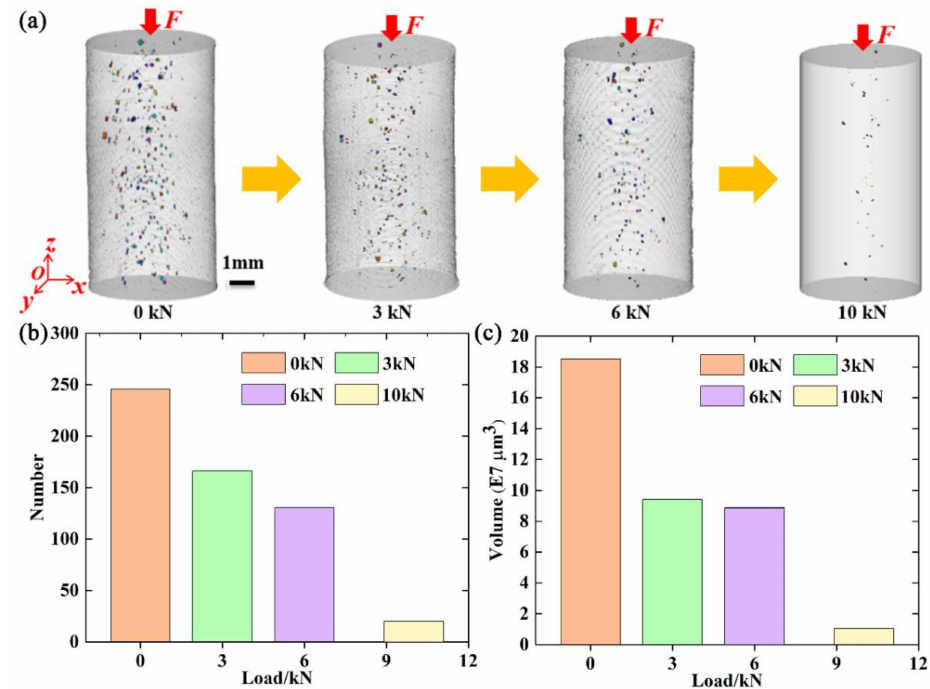
Figure 6. ( a – c ): Three-dimensional volume rendering, number, and volume, respectively, of the pores at different compressive